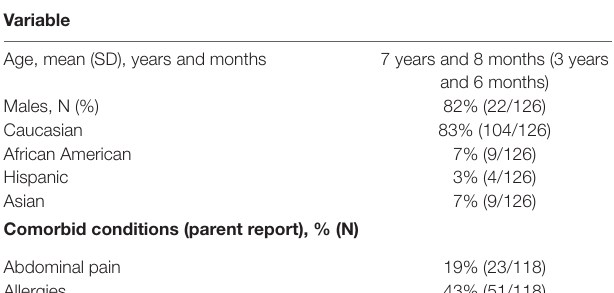
TABLE 1 | ASD participant characteristics (N =